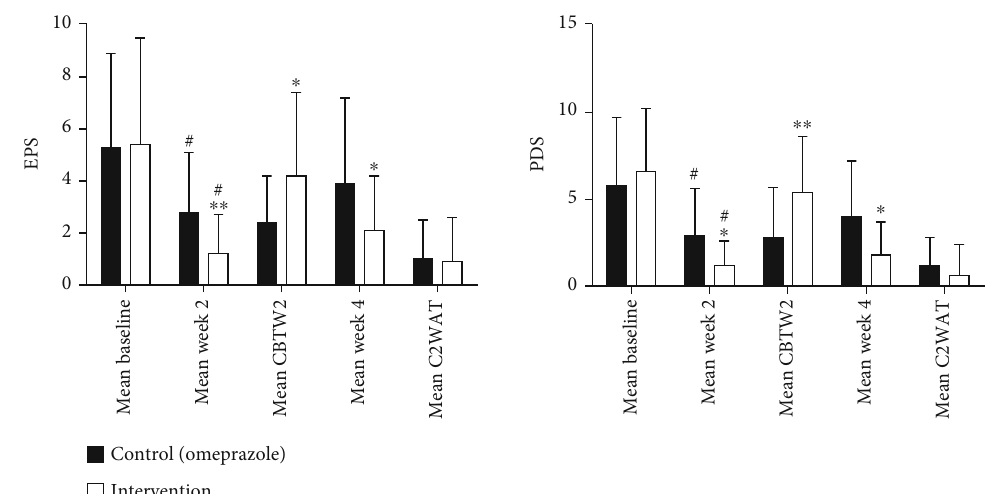
Figure 2: The mean score of PDS and EPS. Intention-to-treat population. EPS: epigastric pain syndrome; PDS: postprandial distress syndrome; Mean CBTW2: mean change baseline to week 2; Mean C2WAT: mean change 2 week after treatment; ∗ p < 0 : 05 control vs. intervention; ∗∗ p < 0 : 01 control vs. intervention; # p < 0 : 001 week 2 vs. baseline. Control (omeprazole), intervention (herbal medicine). Table 2: The mean score of GSRS scale and subscales of GSRS Dyspepsia and GSRS Pain. Intention-to-treat population. Scale